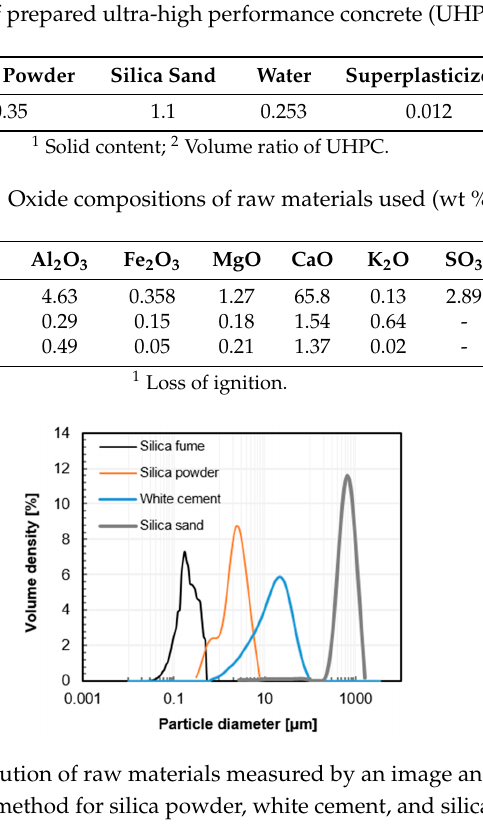
Table 1. Mix proportion of prepared ultra-high performance concrete (UHPC) (wt % of cement).